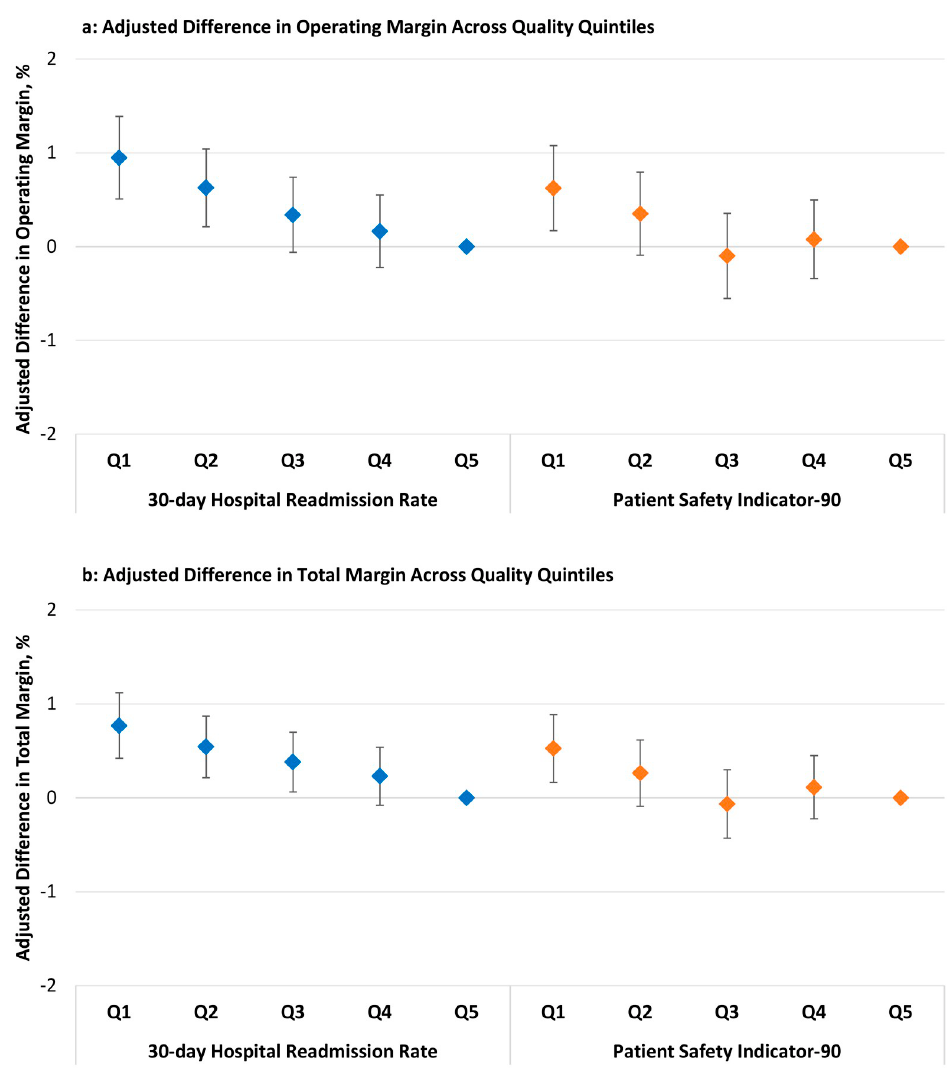
Fig 1. Adjusted difference in operating and total margin across quality quintiles. Hospitals within the lowest 30-day hospital-wide readmission rate quintile and hospitals within the lowest PSI-90 score quintile experienced higher (a) operating margins and (b) total margins compared to their respective highest quality quintiles. Abbreviations: Q = quintile Vertical bars are the 95% confidence intervals. Q5 (worst) is the reference quintile. 30-day Readmission Rates (median): Q1 = 14.6, Q2 = 15.1, Q3 = 15.3, Q4 = 15.6, Q5 = 16.3 Patient Safety Indicator-90 (median): Q1 = 0.75, Q2 = 0.85, Q3 = 0.91, Q4 = 0.96, Q5 = 1.08 For readmission rates and PSI-90 scores, higher values represent lower